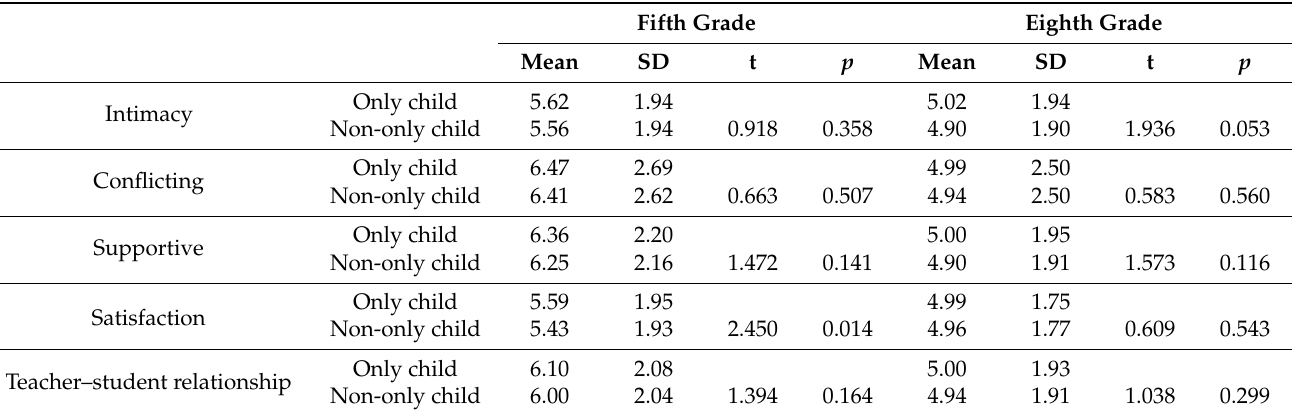
Table 4. Teacher-student relationships with intimacy, conflict, and supportive dimensions be- fore matching.